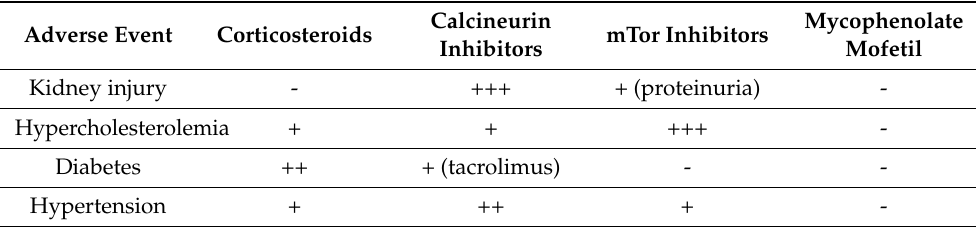
Table 3. Cardiovascular side effects of immunosuppressive drugs (adapted with permission